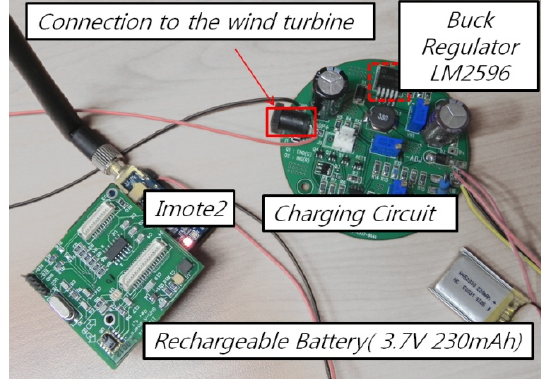
Figure 11. Charging system for the wireless sensor